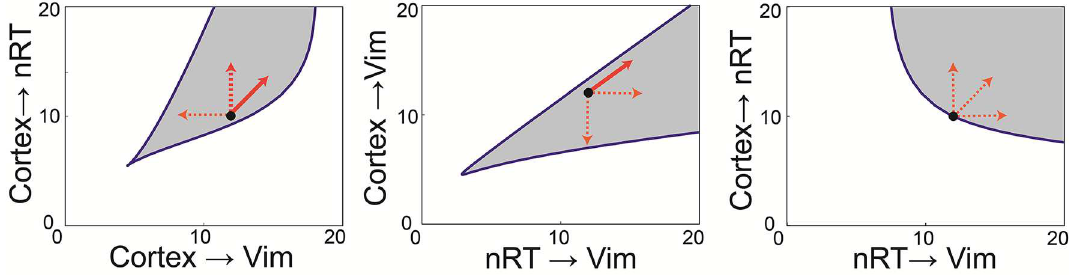
Fig 5. Bifurcation analysis of the connection weights. The relationship between the six connectionweights can be examinedby using bifurcation analysis, which allows us to co-vary any two parameters at a time and trace out the regionin parameter space where the bifurcation leadingto oscillatory activity occurs. In this way, we can split the parameter space into oscillatory(shaded)and non-oscillatory regions and therefore make predictions about the network structure in the pathological state. Furthermore, we examinedthe frequency of the oscillationsthroughoutthese shaded regionsand found that the frequency of oscillations does not remain constant. In fact, as parametersvaried from the default values (black circle), the frequency increased(solid line) or decreased (dashedline) as shown in the plots. The frequencyof oscillations we observedwithin these regions however,was between2 Hz and 8